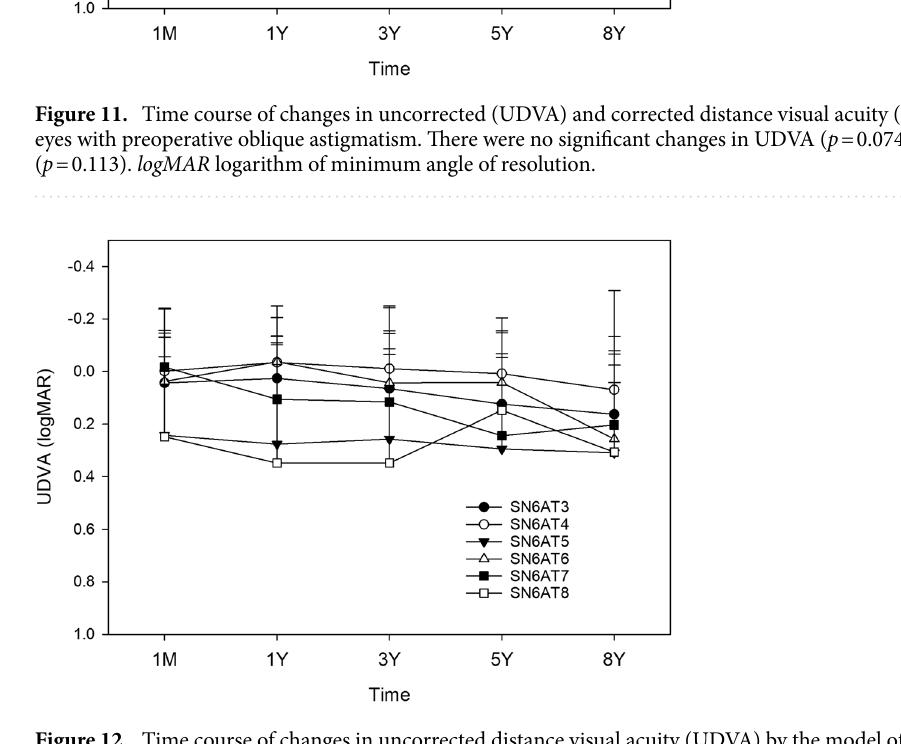
Figure 12. Time course of changes in uncorrected distance visual acuity (UDVA) by the model of toric IOLs. UDVA was not different among the models ( p > 0.05). logMAR logarithm of minimum angle of